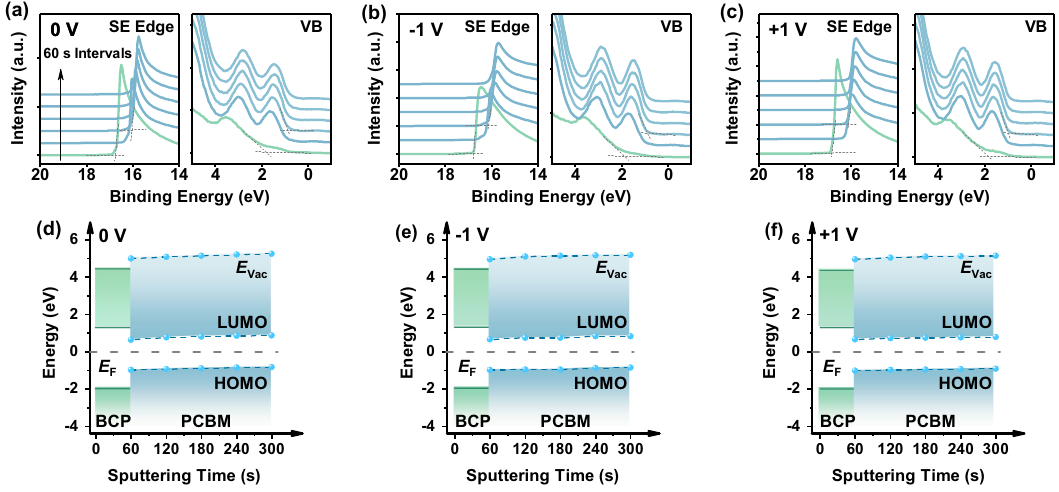
Fig. 3 Depth-dependent UPS spectra and energy bands. a – c Helium I α ( hv = 21.22 eV) spectra of the secondary electron cutoff (SECO) (right) and valence band (VB) (left) of PSCs with the electric stress (0 V, − 1 V, and + 1 V). Note that the HOMO and φ are determined by line extrapolation of the leading edge. d – f The energy bands taken from the above UPS measurements: d 0 V, e − 1 V, and f + 1 V. HOMO, the highest occupied molecular orbitals. LUMO, the lowest unoccupied molecular orbitals. E F is the Fermi level. E vac is the vacuum